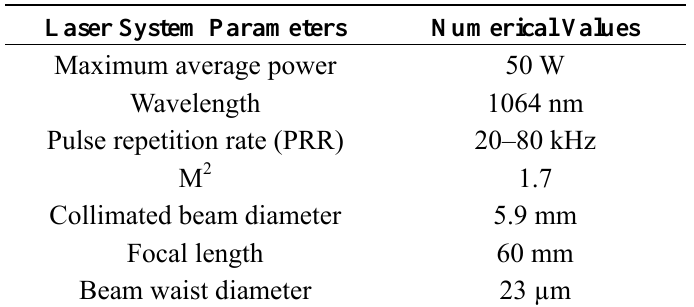
Table 1. Specifications of the laser